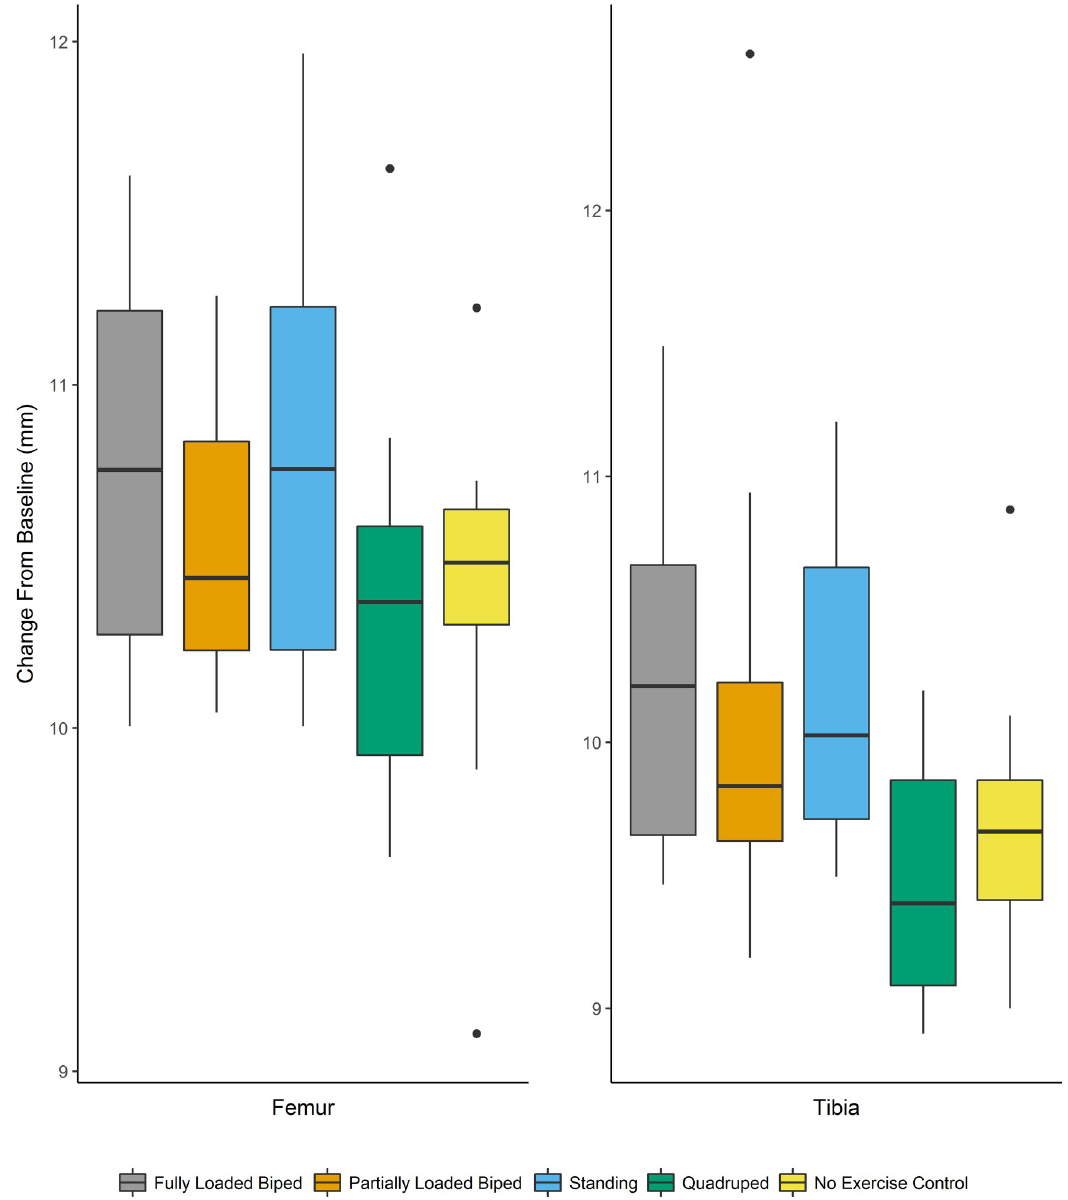
Fig 6. Change from baseline in the femur and tibia over the 12-week experiment. Boxplot of the change in length from baseline (i.e., Week 12—Week 0) in the femur and tibia. The horizontal lines indicate the median, the outer boundaries of the box represent the interquartile range, the whiskers indicate the minimum and maximum, respectively, and the individual points represent